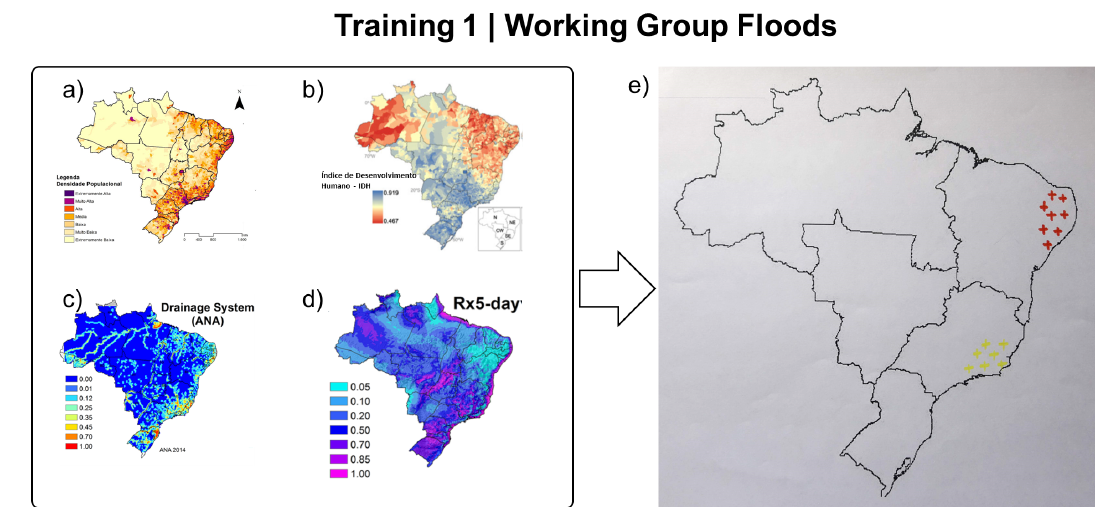
Figure A1. Package of maps used in the first training for mapping climate risk associated with floods. The maps illustrate (a) population den- sity (MMA, 2017), (b) Human Development Index (HDI; Torres et al., 2012), (c) watershed drainage (Debortoli et al., 2017), (d) maximum consecutive 5d precipitation (Rx5-day; Debortoli et al., 2017), and (e) the climate risk map drawn by the participants.